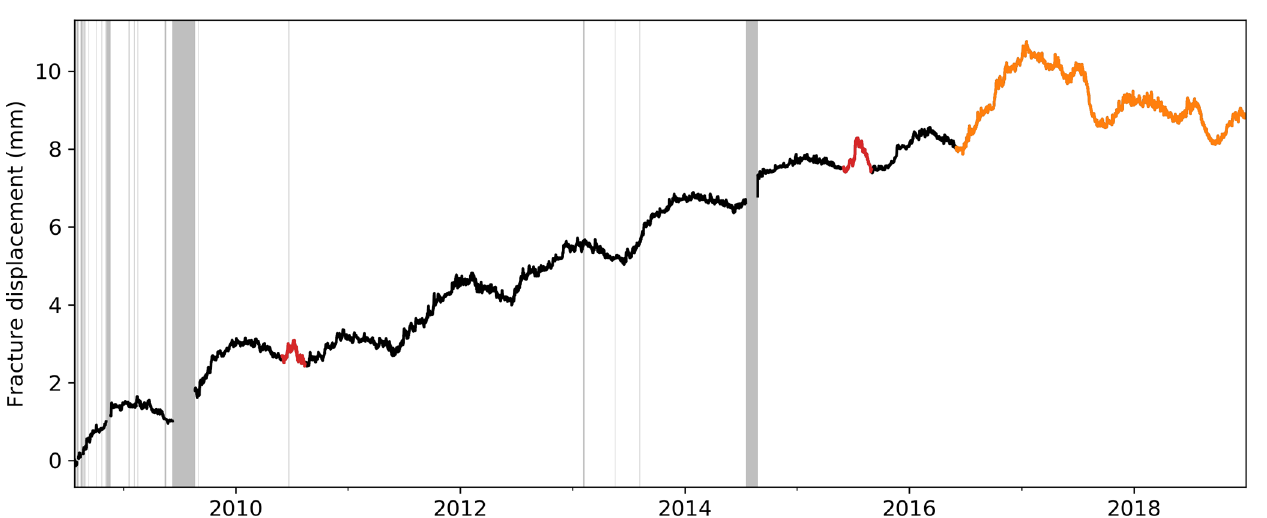
Figure 10. Fracture displacement measured perpendicular to the fracture at position MH03. Gray bars indicate data